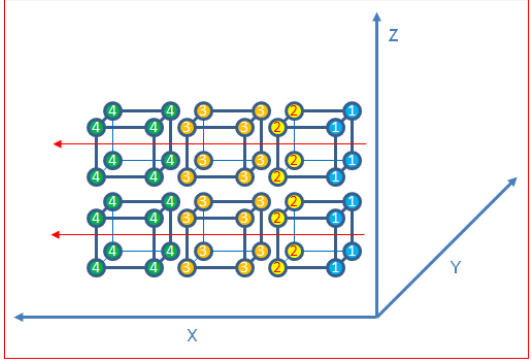
Figure 14. IDs 1 and 2 represent two objects at the same depth, while IDs 3 and 4 represent two objects at different depths.